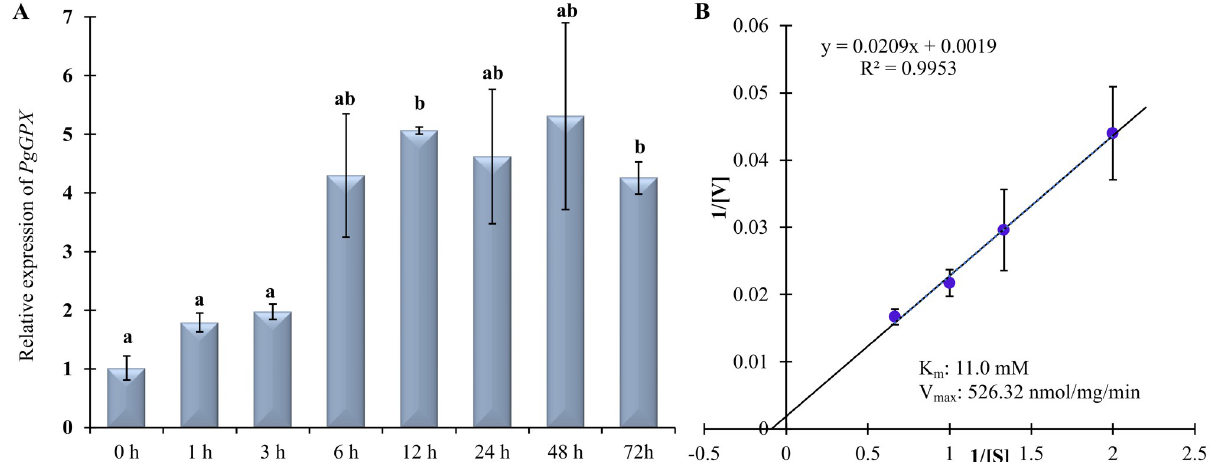
Fig 1. Transcript profiling and enzyme kinetics of PgGPx. (A) A time-dependent expression analysis of PgGPx gene was carried out in response to 100 μ M CdCl 2 in Pennisetum gluccum seedlings for 72h using quantitative real-time PCR. Relative level of PgGPx was normalized with respect to the house keeping tubulin gene. Data were presented as mean expression value ± standard deviation of three replicates (n = 3). Different letters above the bar showed significant difference between the treatments and plant genotypes (P < 0.05, ANOVA; post hoc test). (B) PgGPx illustrates GST activity. Hanes-Woolf plot was generated to depict the enzyme kinetics of PgGPx in the presence of varying concentration of reduced glutathione and a constant 1-Chloro-2,4-dinitrobenzene (CNDB). Experiments were repeated three times and the enzyme kinetics values were shown in the inset.